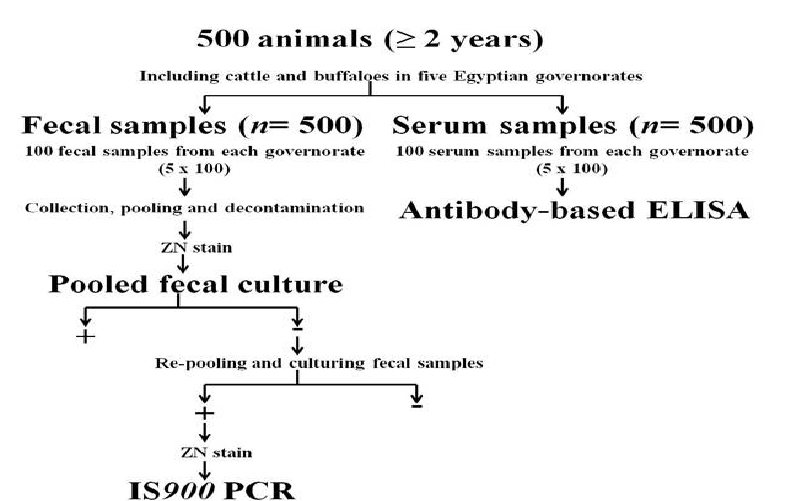
Table-1: The location, the animal spp. and number of fecal and serum samples collected from each spp. Holstein-Friesian cattle and buffaloes housed in five Egyptian governorates were used to collect fecal and serum samples (500 each) and tested in the present study for epizoology of JD in Egypt. Governorate Animal